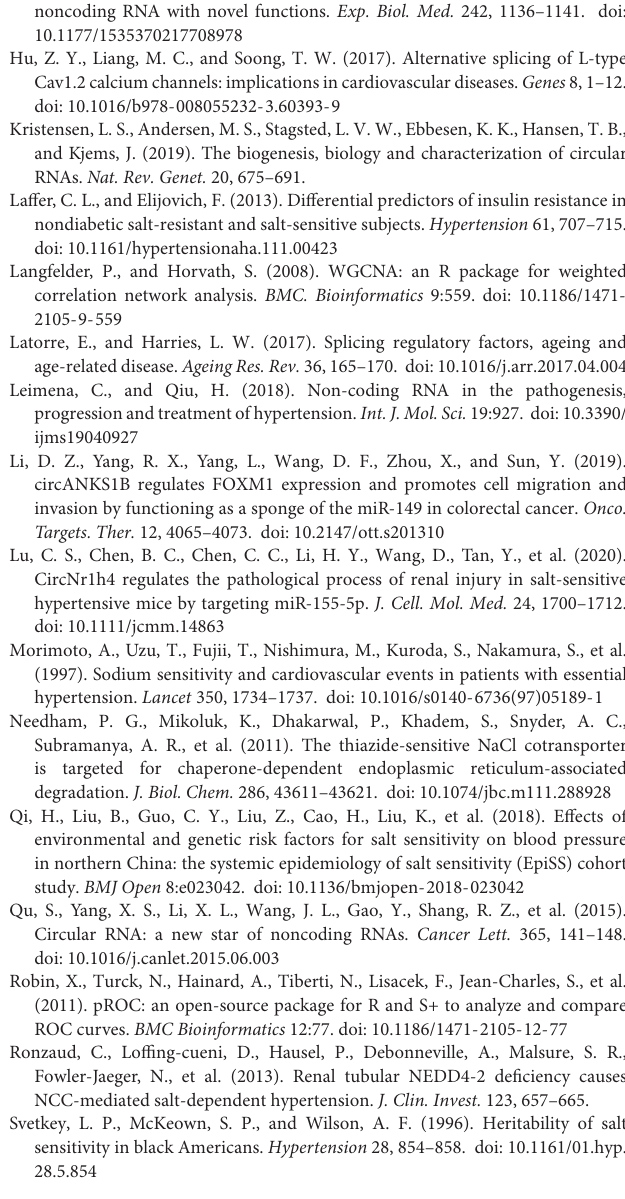
TABLE S1 | Hub genes of salt sensitivity of blood